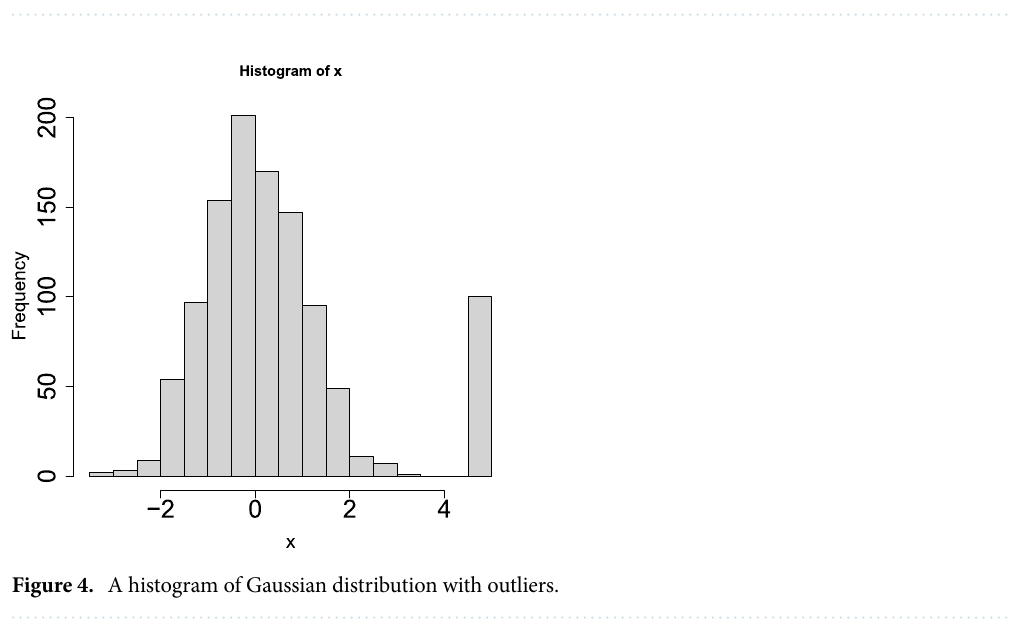
Figure 3. Histogram of 1 − P i of the MAQC data set with PCA-based unsupervised FE Left: P i s by Eq. (6) using SD σ 2 directly computed from u 2 i , right: using SD optimized to obey the Gaussian distribution as much as possible.